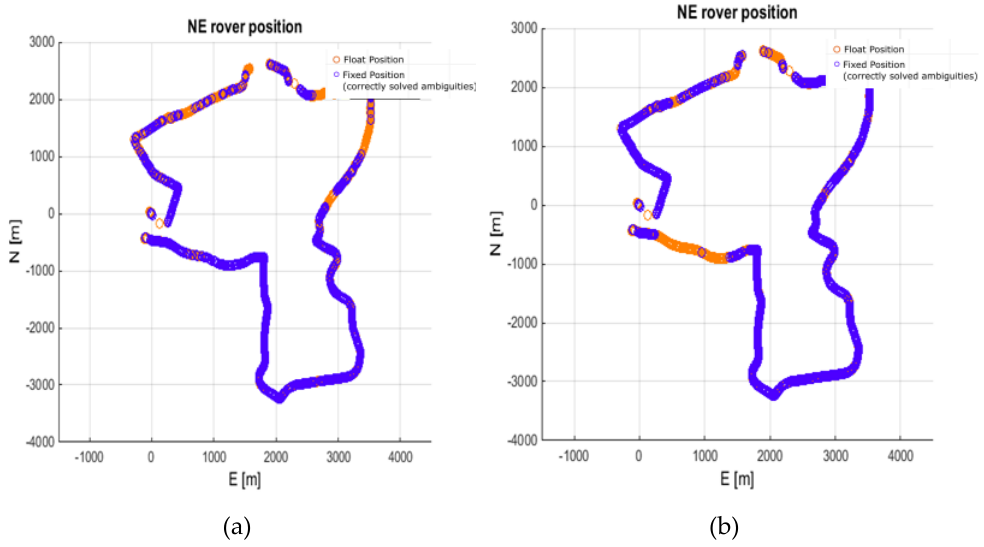
Figure 13. Rover trajectory from processing 62 to 82 km baselines (MULTI3). ( a ) No ionospheric corrections; ( b ) With ionospheric corrections.